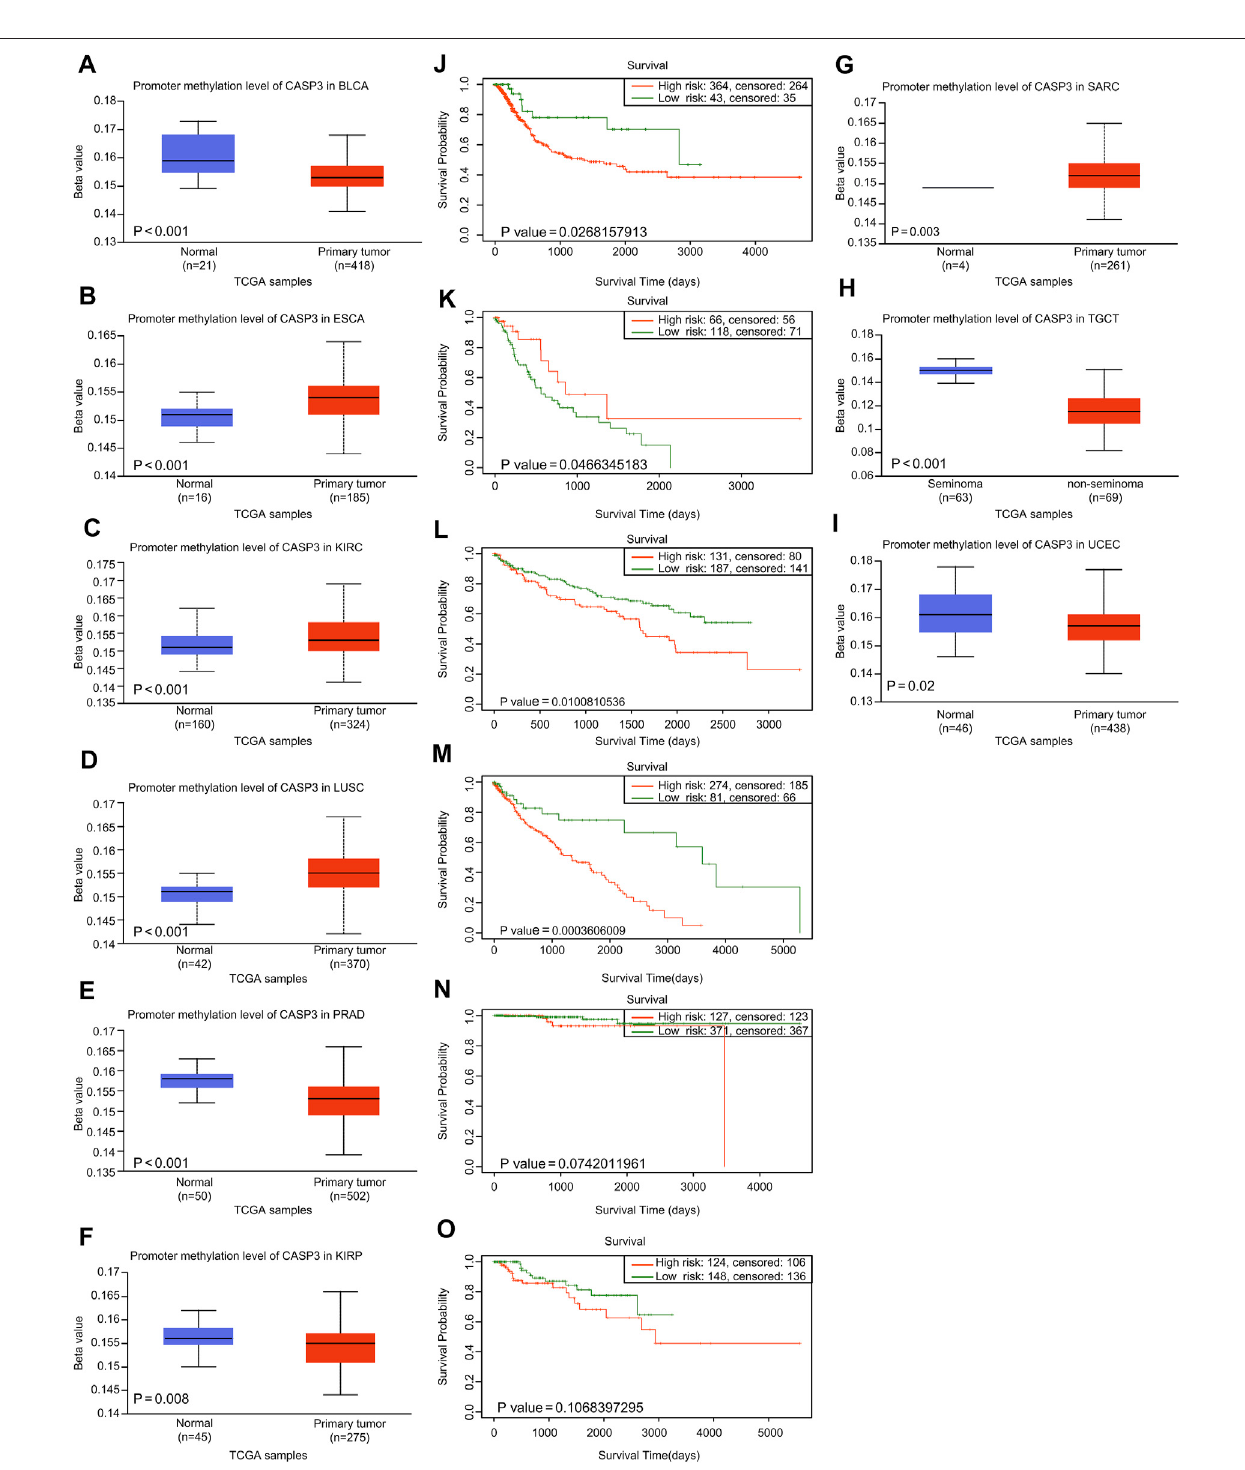
FIGURE 5 | Relationship between CASP3 expression and promoter methylation in different tumours. (A – H) Relationship between CASP3 expression and promoter methylation in BLCA, ESCA, KIRC, LUSC, PRAD, SARC (Sarcoma), TGCT, UCEC. (I – M) Kaplan-Meier survival analysis of the relationship between CASP3 promoter methylation level and OS in BLCA, ESCA, KIRC, LUSC, PRAD.